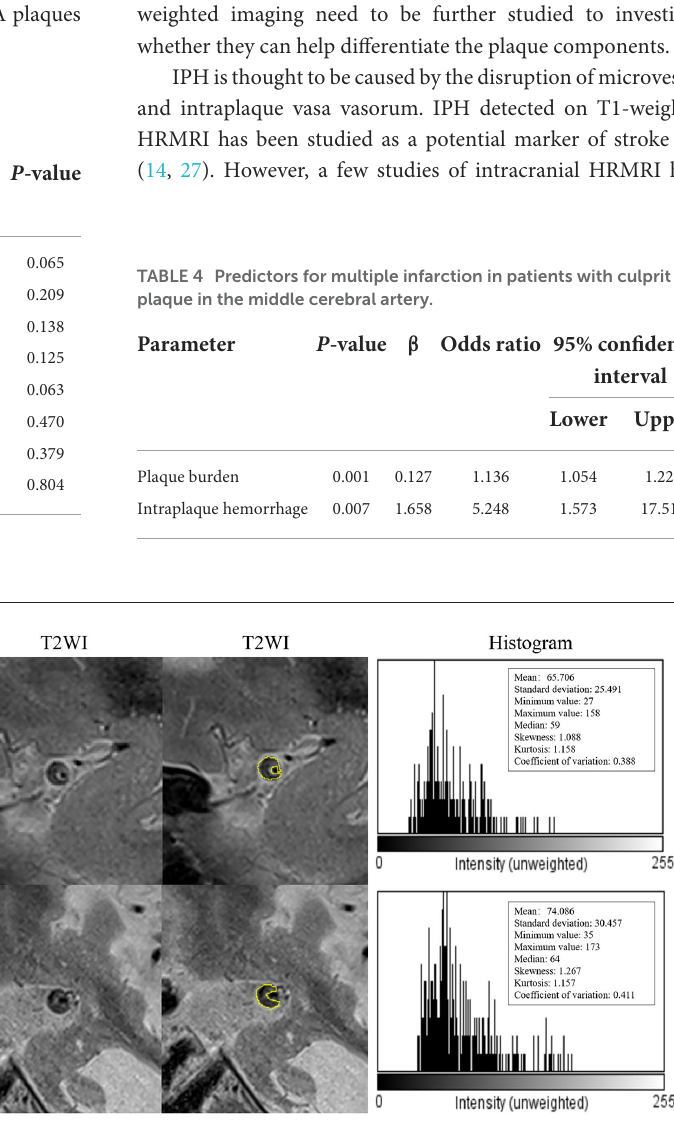
FIGURE3 (A) A 73-year-old man presented with right-side weakness for 3 days. DWI showed an oval acute infarct in the left corona radiate. 3D-TOF-MRA demonstrated the stenosis located on the left MCA. The T2-weighted HRMRI demonstrated an eccentric atherosclerotic plaque with heterogeneity intensity at the most stenotic site of the right MCA. The outer wall boundary of the plaque can be outlined. The quantitative histogram parameters based on T2WI are shown on the right. (B) A 59-year-old man presented with right-side weakness and speech disorder for 5 days. DWI showed multiple infarctions in the left MCA territory. 3D-TOF-MRA demonstrated the stenosis located on the left MCA. The T2-weighted HRMRI demonstrated an eccentric atherosclerotic plaque with heterogeneity intensity at the most stenotic site of the right MCA. The outer wall boundary of the plaque can be outlined. The quantitative histogram parameters based on T2WI are shown on the